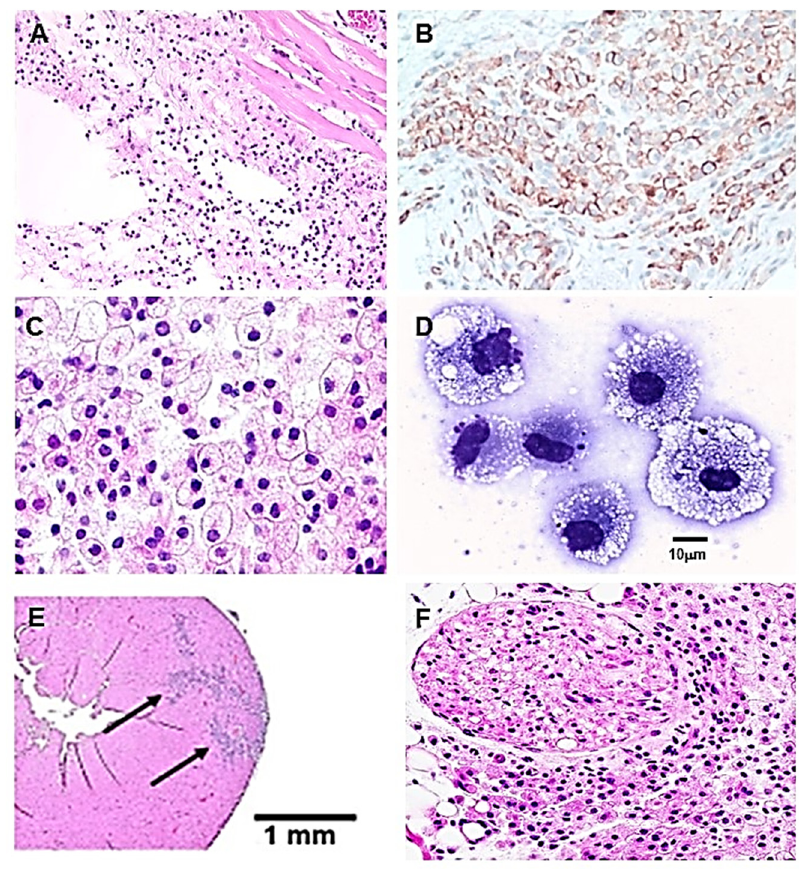
Figure 2. Demonstration of macrophage recruitment by α -gal nanoparticles, in various tissues of anti-Gal producing α 1,3galactosyltransferase knockout (GT-KO) mice. ( A ) Macrophage recruitment 24 h after intradermal injection of 10 mg α -gal nanoparticles. The empty oval area is the space formed by the injection of α -gal nanoparticles. The nanoparticles were dissolved by alcohol during the processing for hematoxylin & eosin staining (H&E × 100). ( B ) Macrophages identified at the injection site, 4 days post injection, by specific staining with the anti-F4/80 antibody coupled to peroxidase (HRP) ( × 200). ( C ) The intradermal injection site after 7 days is full of many large macrophages containing vacuoles, suggesting activation of these cells (H&E × 400). ( D ) Individual macrophages, similar to those in ( C ) migrating into polyvinyl alcohol (PVA) sponge disc containing 10 mg α -gal nanoparticles and implanted subcutaneously into GT-KO mouse for 7 days. The many vacuoles in the cytoplasm of the macrophages are of the anti-Gal coated α -gal nanoparticles internalized by the macrophages (Wright staining, ×1000). ( E ). Mouse healthy heart, 4 days following two injections of α -gal nanoparticles (each 10 μ l of 10 mg/mL nanoparticles). Recruited macrophages are identified by arrows (H&E × 20). ( F ). Infiltration of macrophages into an area near a sciatic nerve branch (oval structure), 4 days post injection of α -gal nanoparticles (H&E × 200). Modified from ref. [57].